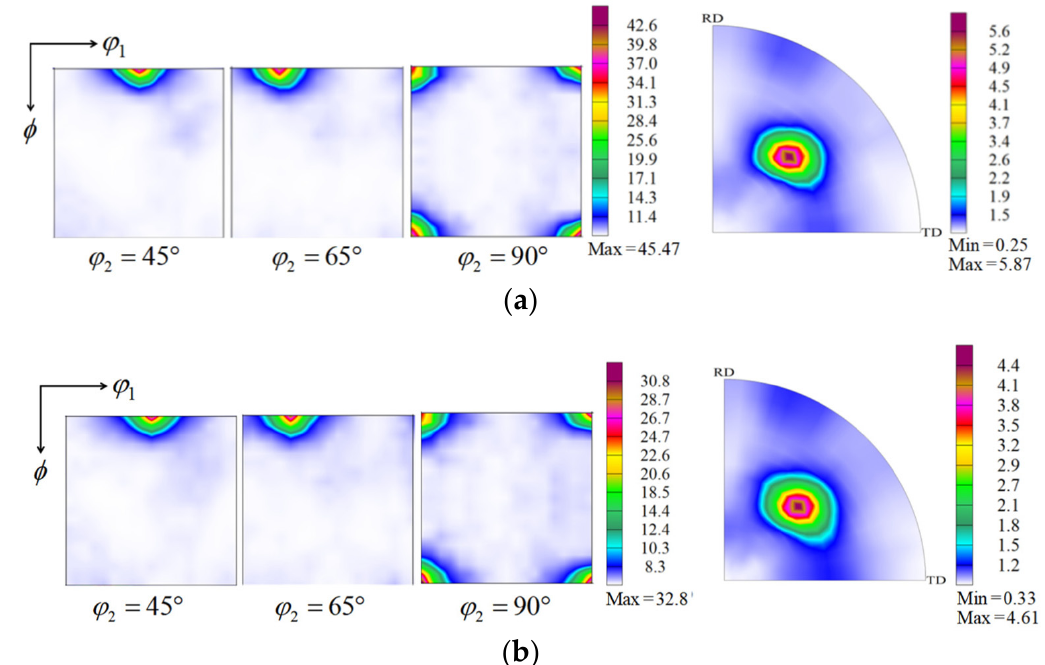
Figure 1. ODF and {111} pole figure for ( a ) T4 and ( b ) O temper sheets.